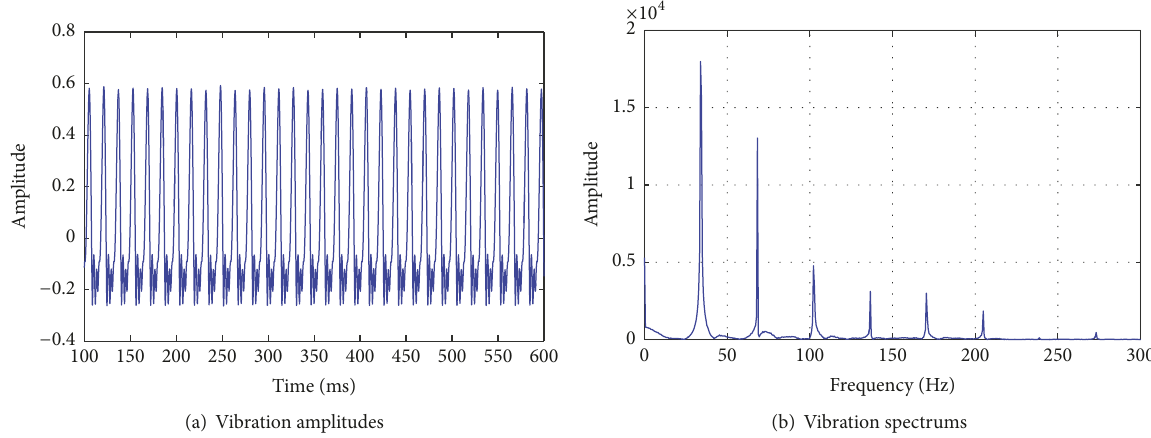
Figure 10: The horizontal direction response of the position of pedestal looseness ( 𝜆 = 0.3 , 𝛿 = 0.00002 m).